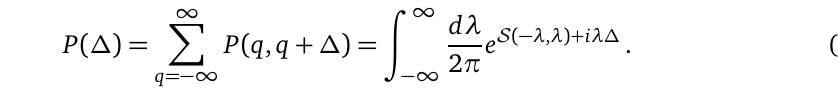
Figure 2: Joint distribution of heat and work together with its marginals for g /κ = 1 [ (a) and (b) ] and g /κ = 0.05 [ (c) and (d) ] . Here κ ≡ κ for heat ( q ) and work ( w ) [ (a) and (c) ] features negative values, as well as probabilis- tic first law violations (non-negative values away from the diagonal dashed line). As discussed in the main text, these features arise from quantum coherence, preventing a back-action-free and precise measurement of work. The marginal distributions of heat and work [ (b) and (d) ] are described by a discrete and continuous distribution respectively. This is a consequence of the fact that photons can be counted one by one while Cooper pairs cannot. The dashed line and dark blue bars in (d) show the analytic expressions obtained for g (cid:28) κ . For large g ( ∼ 20 κ ), the distributions look qualitatively the same as for g ∼ κ (not shown). Parameters: n h gt = κ t = 150 [ (a) and (b) ] , gt = 600, κ t = 12 (cid:48) 000 [ (c) and (d) ] , ensuring the same mean values in panels (a) and